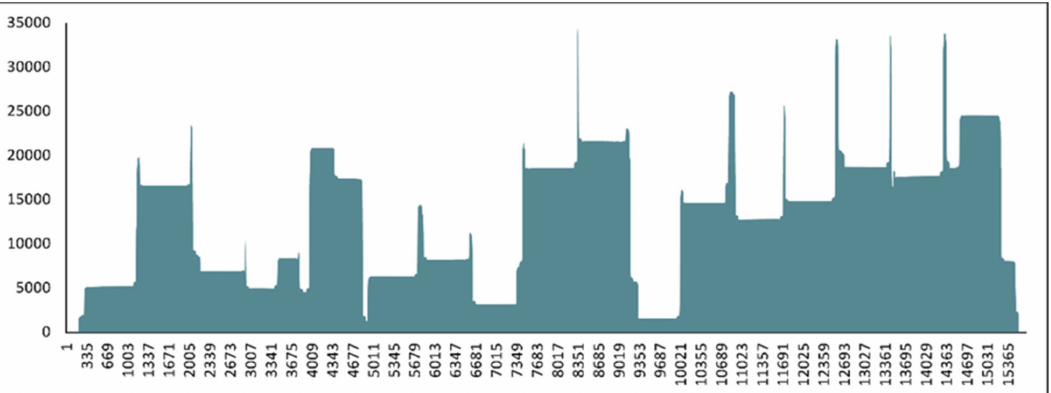
Figure 1. Visualization of sequencing coverage via the amplicon-based sequencing method for the sample from 2006, with all primer sets (1000 and 2000 bp). The horizontal scale represents the genomic position, while the vertical scale displays the coverage values of the sequencing